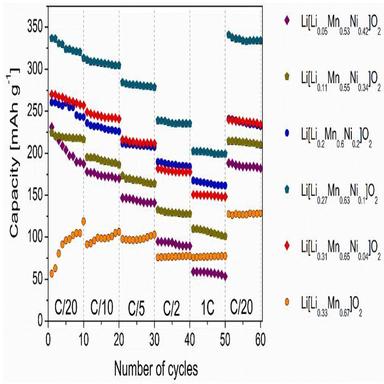
Discharge capacities of the Li/Li+/LiO2 cells as a function of cycle number for various current loads.